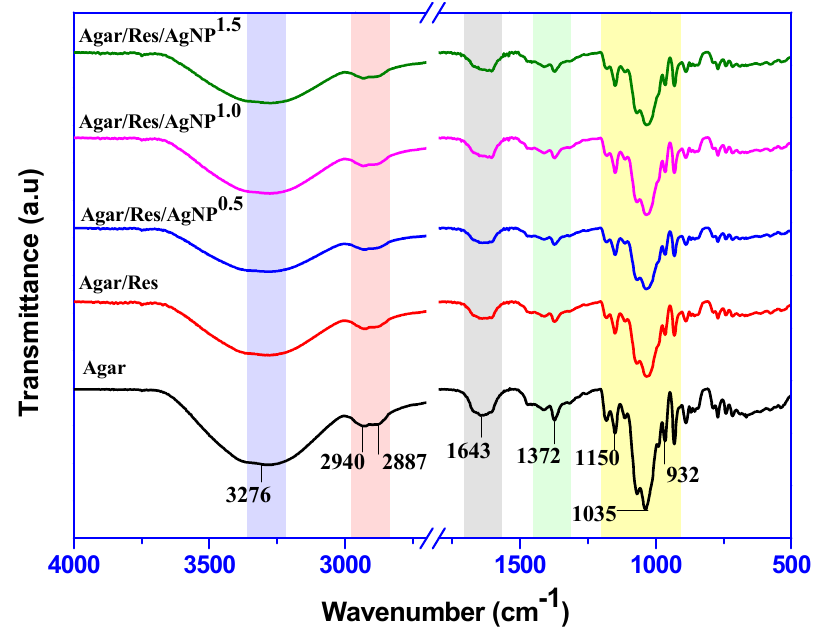
Figure 3. FTIR spectra of the agar-based composite films. Table 2. Mechanical properties, WVP, and WCA of the agar-based composite films.